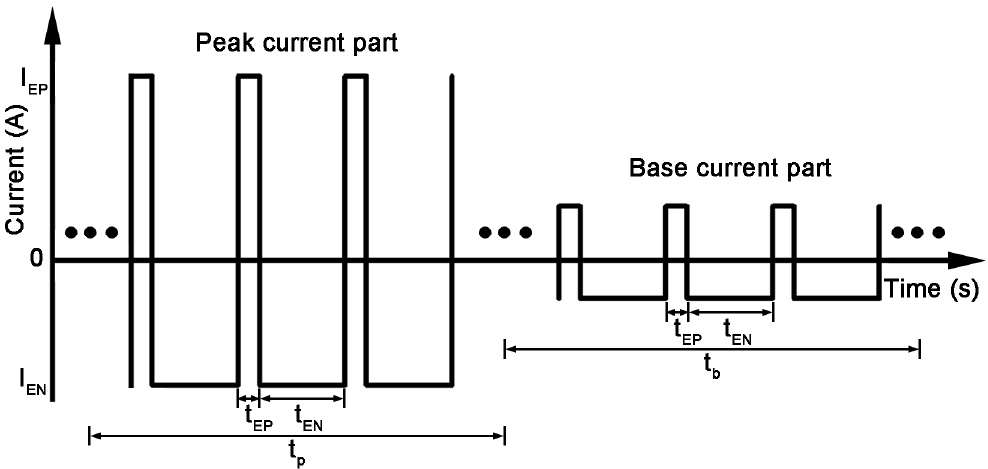
Figure 2. Schematic of the waveform used in this study.